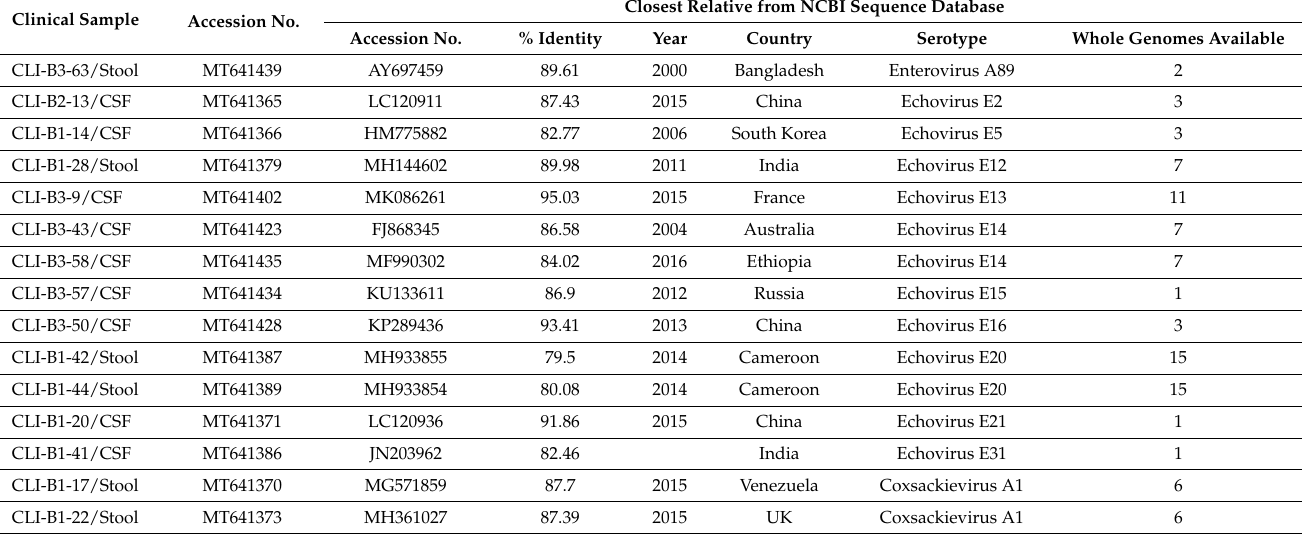
Table 3. Entire capsid sequences and genome coverage data of uncommon EVs from this